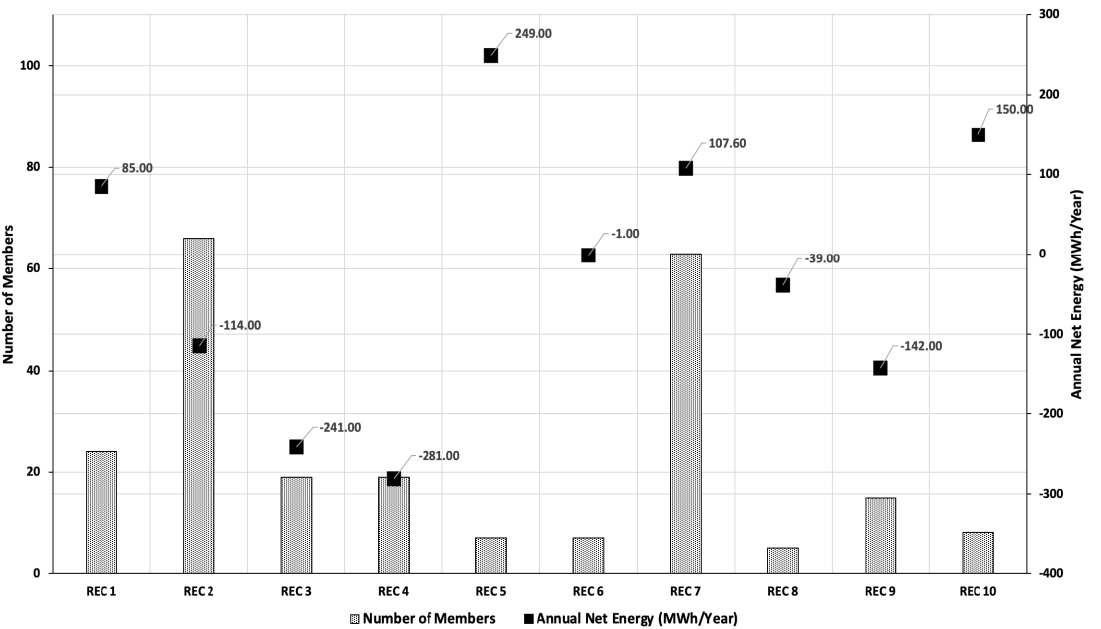
Figure 19. Number of members and annual net energy by REC — complete-link.